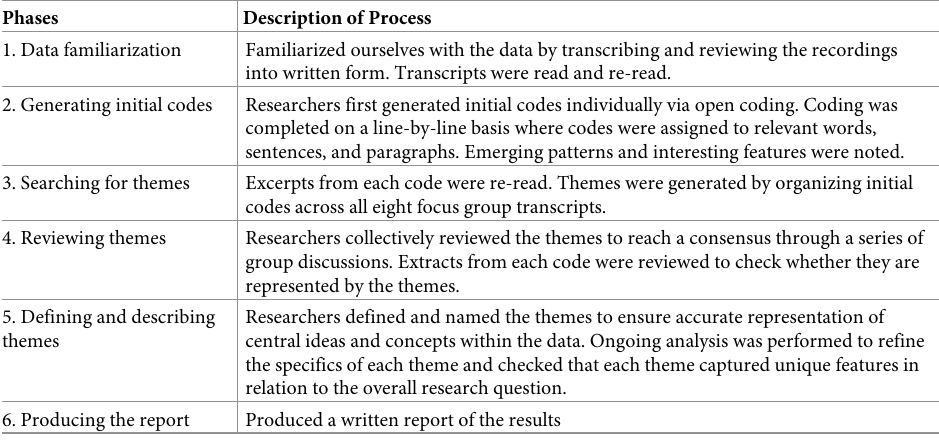
Table 1. Phases of thematic analysis adapted from Braun and